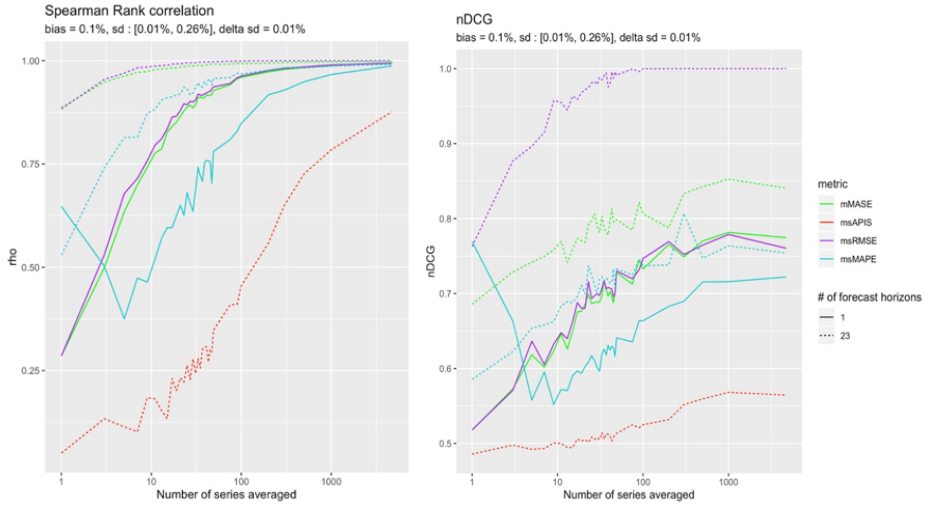
Figure 10. Spearman Rank correlation and nDCG for ( − − − )